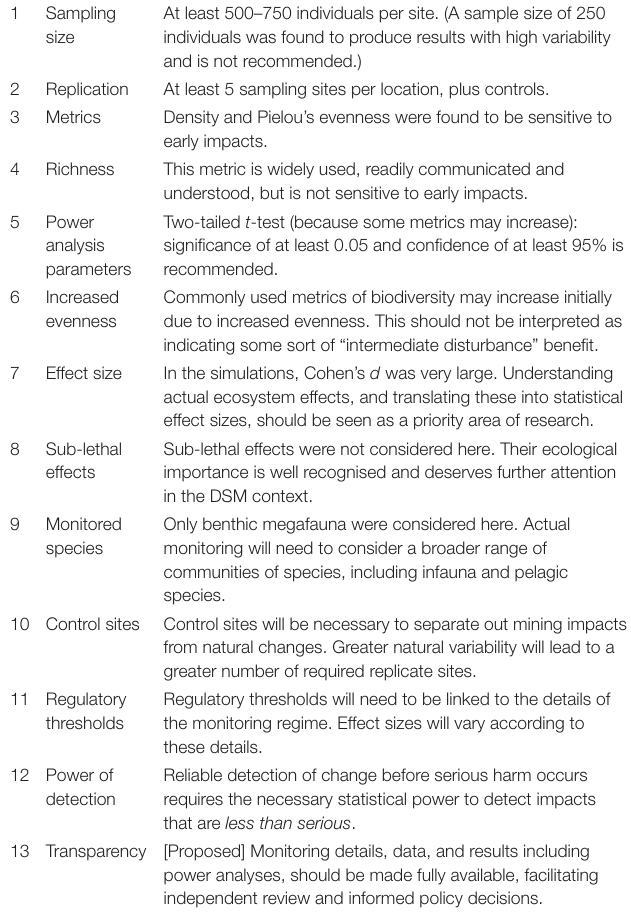
TABLE 6 | Summary of findings and recommendations (in the order presented in section